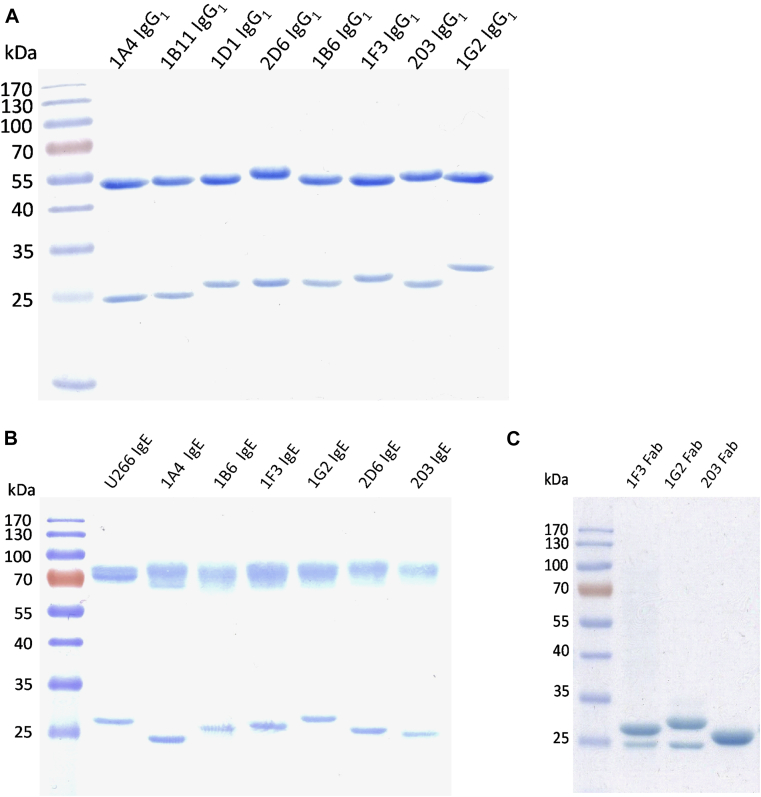
Purity of recombinant SAE-specific IgG1, IgE, and Fab antibodies. All recombinant SAE-specific IgG1(A), IgE (B), and Fab (C) antibodies were transiently expressed in Expi293F cells and purified by means of protein A, anti-IgE, or LambdaFabSelect affinity chromatography, respectively. Five micrograms of each antibody was fractionated by using 12% SDS-PAGE under reducing conditions before Coomassie Blue staining.